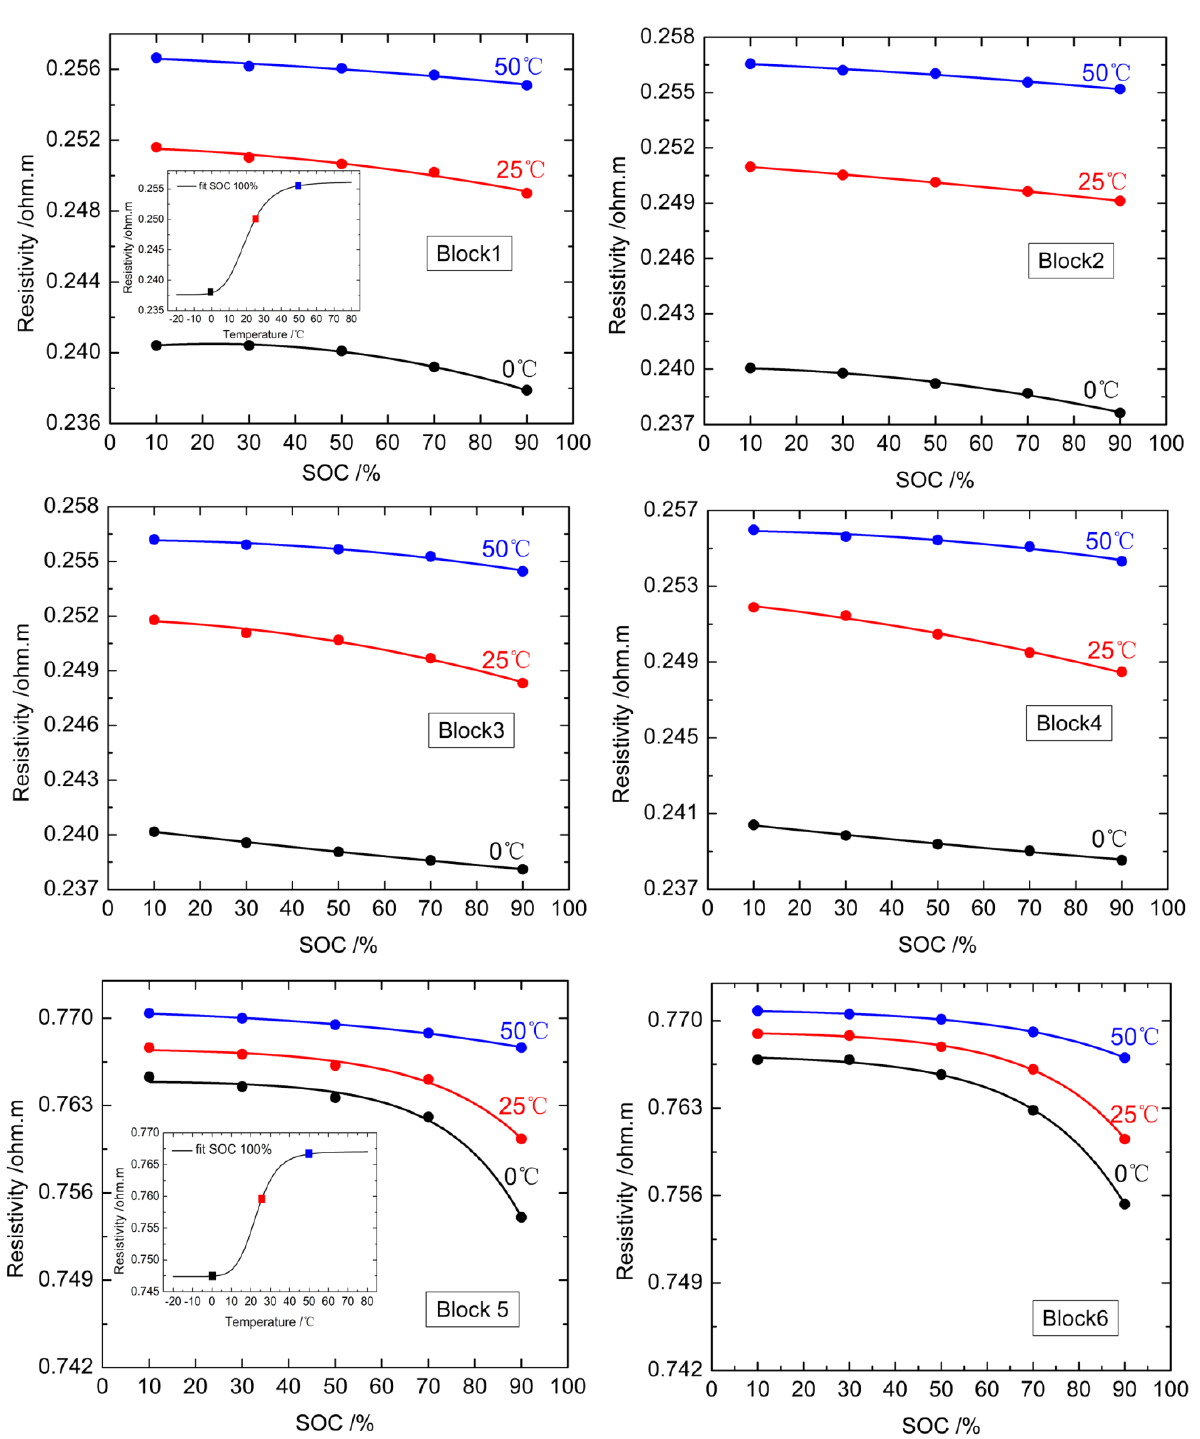
Figure 12. Variations of apparent resistivity ρ with SOC 𝑠 in side A of 4.5 Ah battery. Each block in graph is the average of ten independent measurements made at 0, 25 and 50 °C. The dotted lines are the exponential decay fit to all the